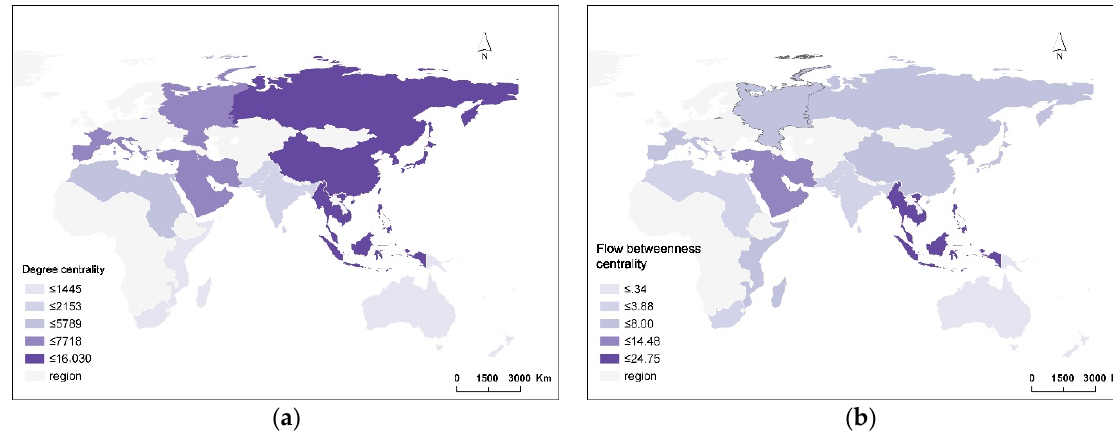
Figure 6. Centrality analysis: ( a ) Regional maritime connection capacity; ( b ) Regional maritime transshipment capacity. The value is calculated with UCINET 6.